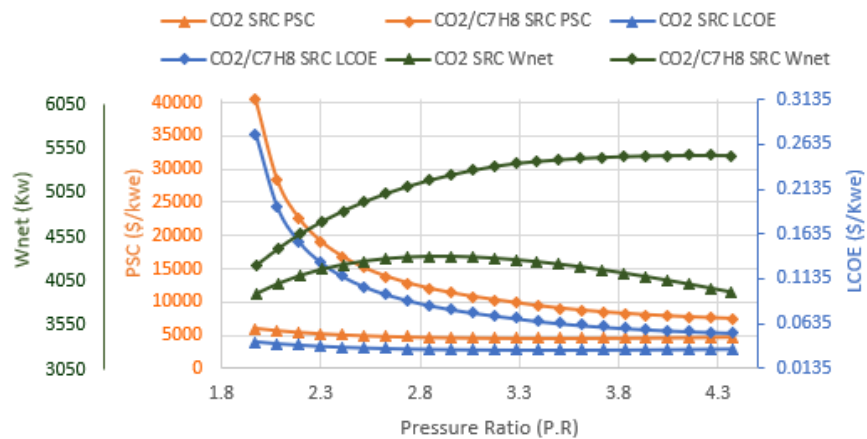
Figure 6. Power output, plant-specific cost, and levelized cost of electricity for CO 2 SRC and / 0.1C 0.9CO 2 /0.1C 7 H 8 SRC with respect to pressure ratio. 0.9CO 2 7 H 8 SRC with respect to pressure